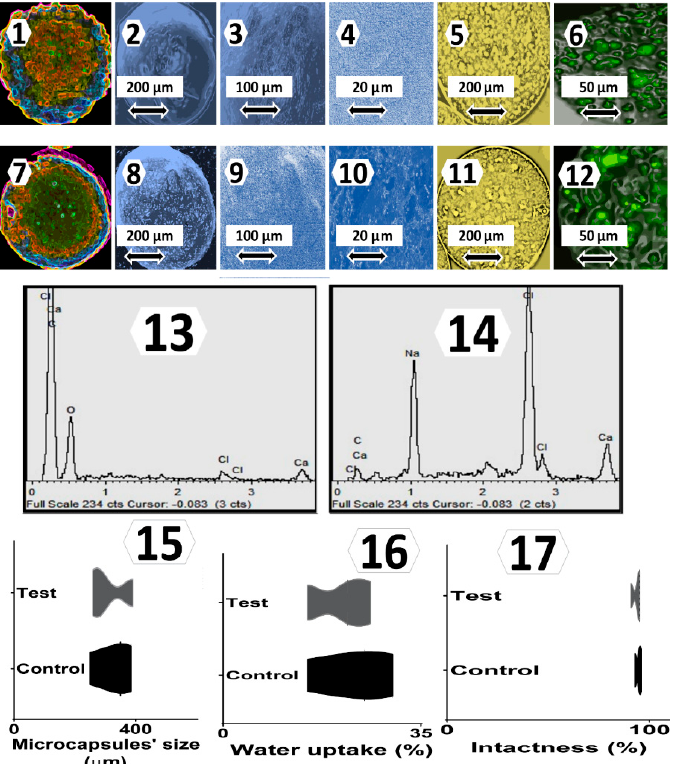
Figure 3. Micro-CT analysis for control ( 1 ) macrocapsules with SEM micrographs ( 2, 5, 6 ), optical microscopy imaging ( 3 ) and confocal microscopy ( 4 ), and micro-CT analysis for treatment ( 7 ) microcapsules with SEM micrographs ( 8, 11, 12 ), optical microscopy imaging ( 9 ), and confocal microscopy ( 10 ). Microcapsules elemental composition of control ( 13 ) and treatment ( 14 ), and size distribution ( 15 ), water uptake ( 16 ) and intactness under shear stress studies ( 17 ) are also presented as mean ±